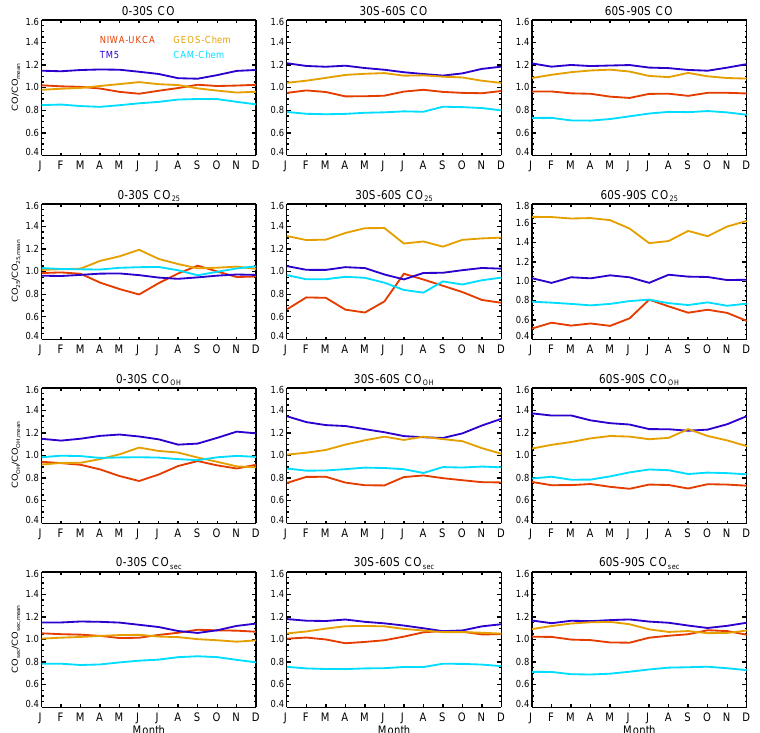
Figure 14. The ratio of individual models to the ensemble-mean columns averaged over three SH regions (0–30, 30–60, and 60–90 ◦ S) for CO, CO 25 , CO OH , and CO sec . Data are for the year